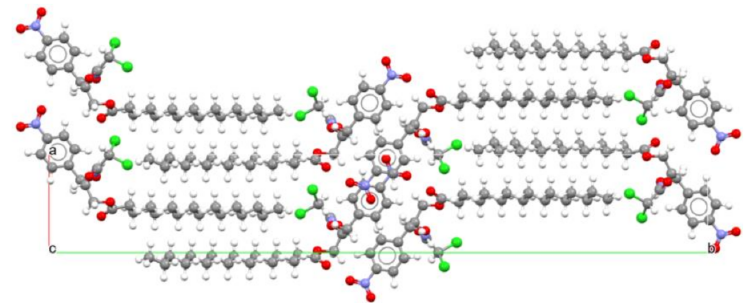
Figure 5. Crystal packing of chloramphenicol palmitate Form B (view down the crystallographic c -axis).